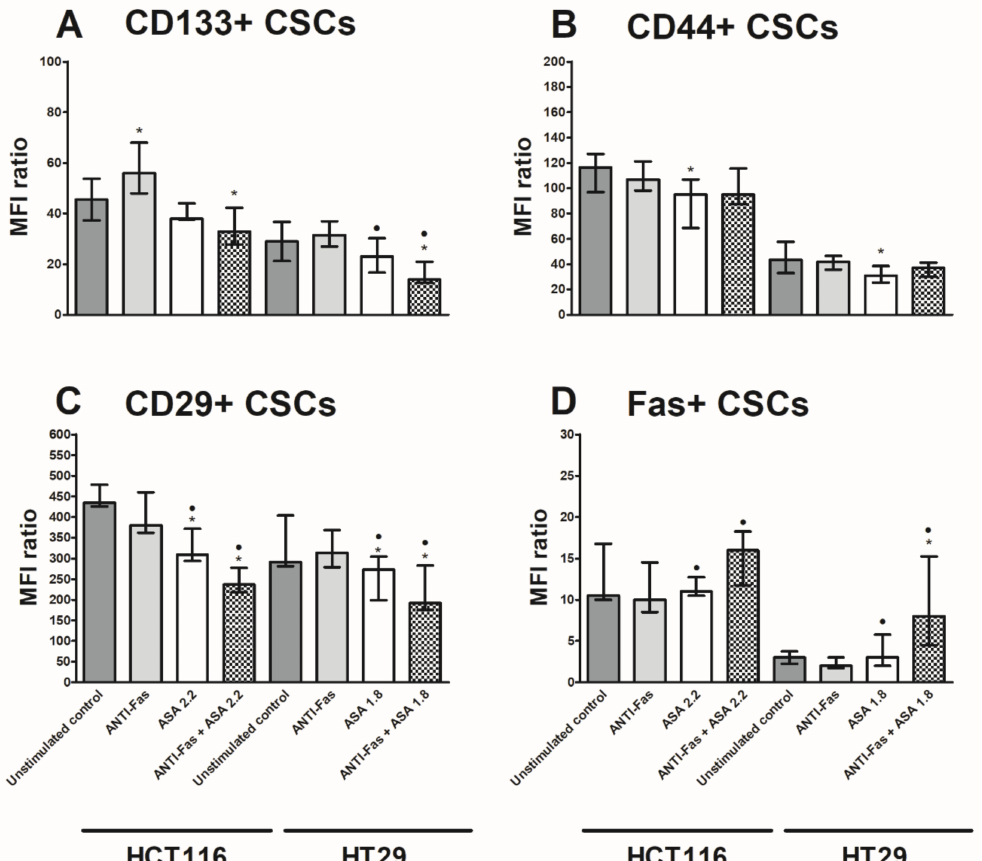
Figure 3. The cytometric analysis of HCT116 and HT29 cells expanded 10 days in spherical forms with agonistic anti-Fas antibody (200 ng/mL) and/or aspirin (ASA) (2.2 mM or 1.8 mM for HCT116 or HT29, respectively). Y-axis presents mean fluorescence intensity (MFI) related to unstained control. Statistically significant differences were assessed by Kruskal-Wallis test followed by Dunn’s test as a post hoc procedure or U Mann-Whitney test. Bars and whiskers represent median ± interquartile range (* p < 0.05 vs control unstimulated cells, • p < 0.05 ASA vs ASA/anti-Fas antibody, n = 12 for each option). Triplicate independent experiments were performed. ( A – D ). The analysis of CD133 + , CD44 + , CD29 + and Fas + colorectal cancer stem cells (CSCs),